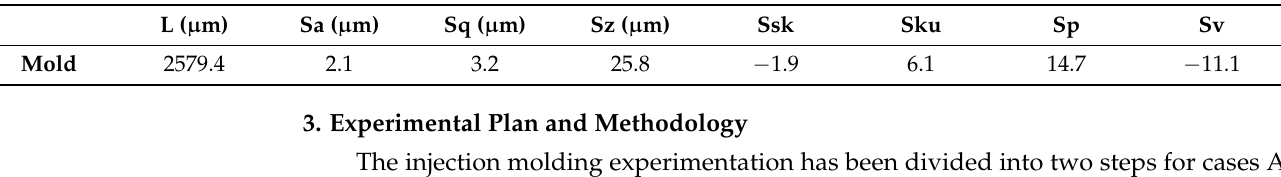
Table 2. Mold length and surface characteristics.